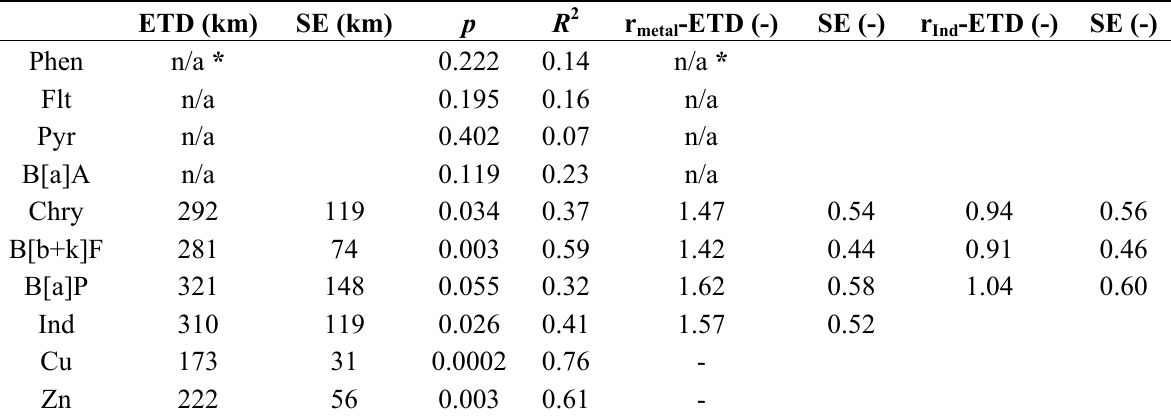
Table 1. Empirical travel distances (ETDs) with standard error (SE), significance level ( p ), coefficient of determination ( R 2 ), and relative experimentally determined travel distances (r -ETD and r -ETD) with SE. metal Ind